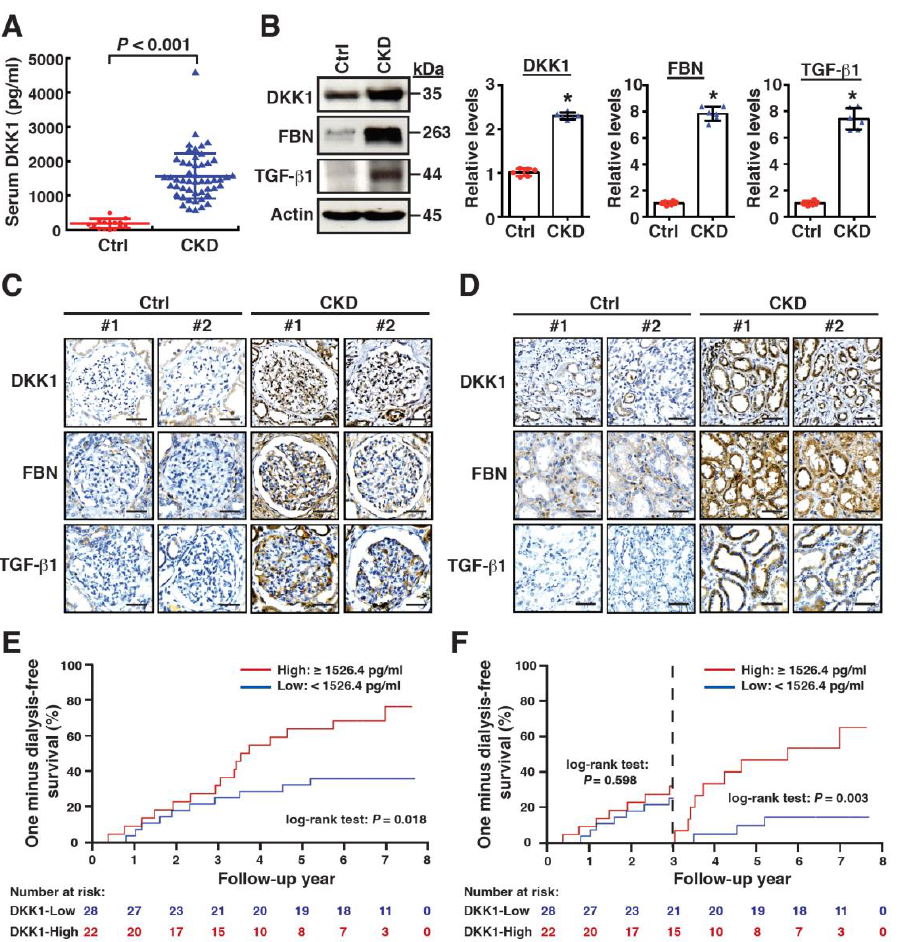
Figure 1. Elevated levels of serum DKK1 are associated with fast progression to ESRD in patients with CKD stages 4–5. ( A ) Serum DKK1 levels in normal controls (n = 15) and in patients with CKD stages 4–5 (n = 50). Data are presented as mean ± SD. ( B ) Western blot analysis for the expression of DKK1, fibronectin (FBN) and TGF- β 1 in renal tissues from non-CKD and CKD subjects. Quantitative data are expressed as mean ± SD. * p < 0.05 versus control subjects (n = 6). ( C ) Chromogenic IHC staining for DKK1, FBN and TGF- β 1 in renal glomeruli of representative non-CKD subjects (#1 and #2) and CKD subjects (#1 and #2). Scale bars: 20 µ m. ( D ) Chromogenic IHC staining for DKK1, FBN and TGF- β 1 in renal tubules of representative non-CKD subjects (#1 and #2) and CKD subjects (#1 and #2). Scale bars: 20 µ m. ( E ) One minus dialysis-free survival analysis of CKD 4–5 patients with high